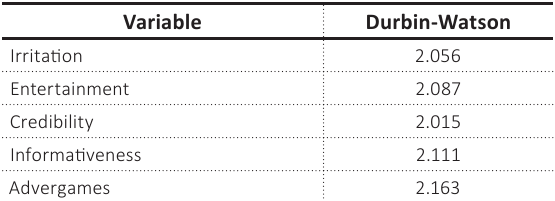
Table 10. Durbin-Watson statistics results